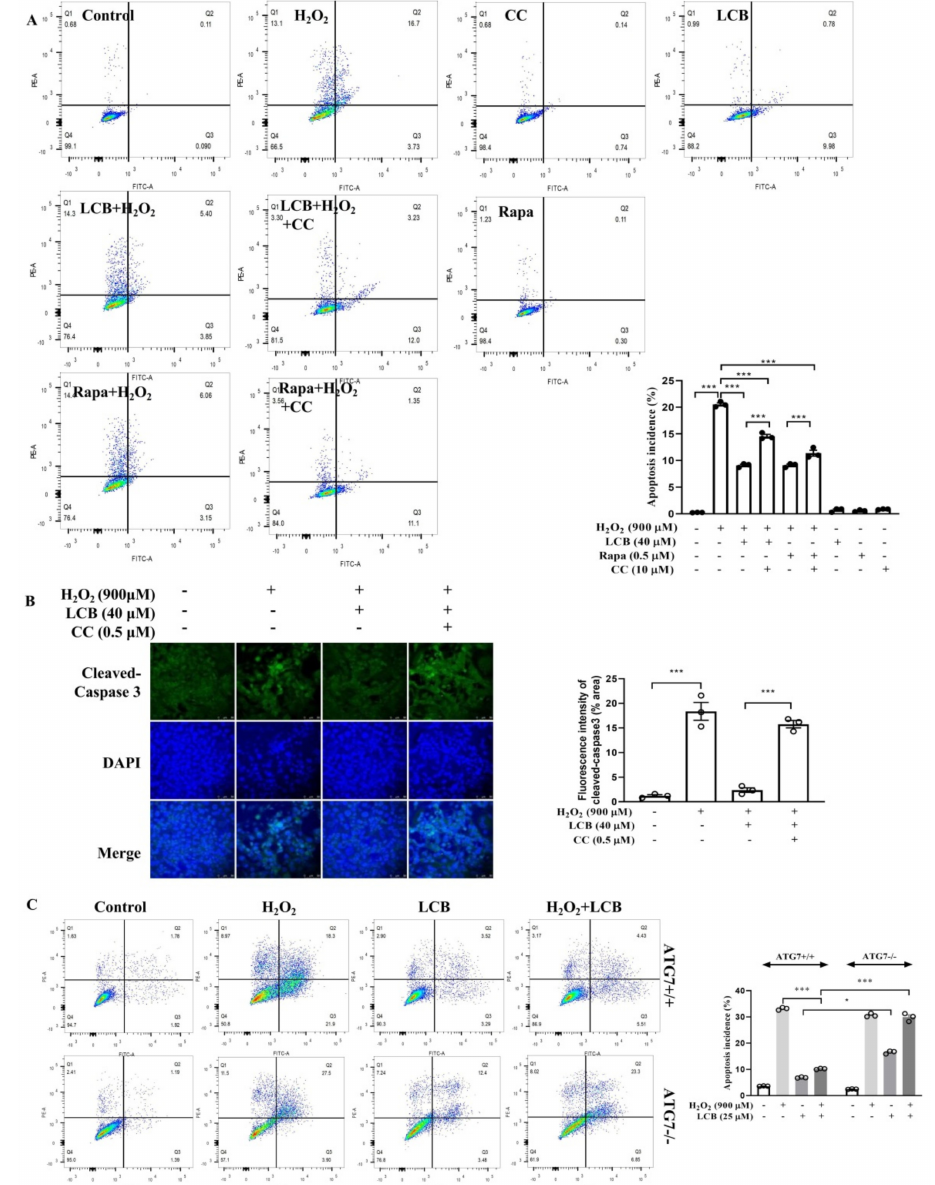
Figure 8. LCB rescued H 2 O 2 -induced apoptosis via enhancing autophagy. ( A ) PC-12 cells